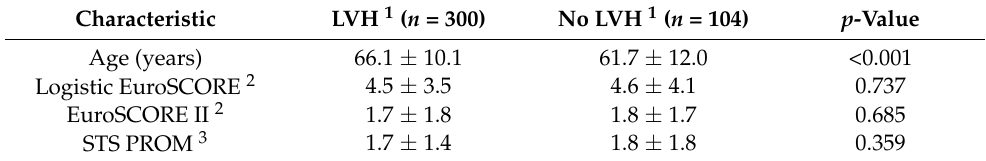
Table 2. Baseline Table 2. Baseline characteristics.